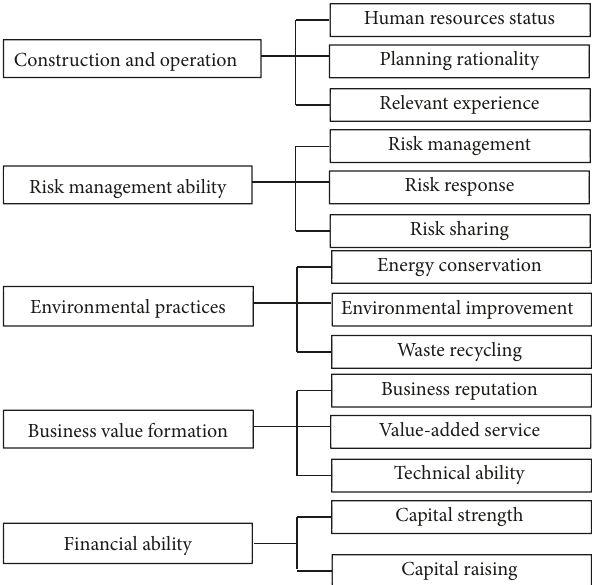
Figure 1: The evaluation criteria of private sector under PPP